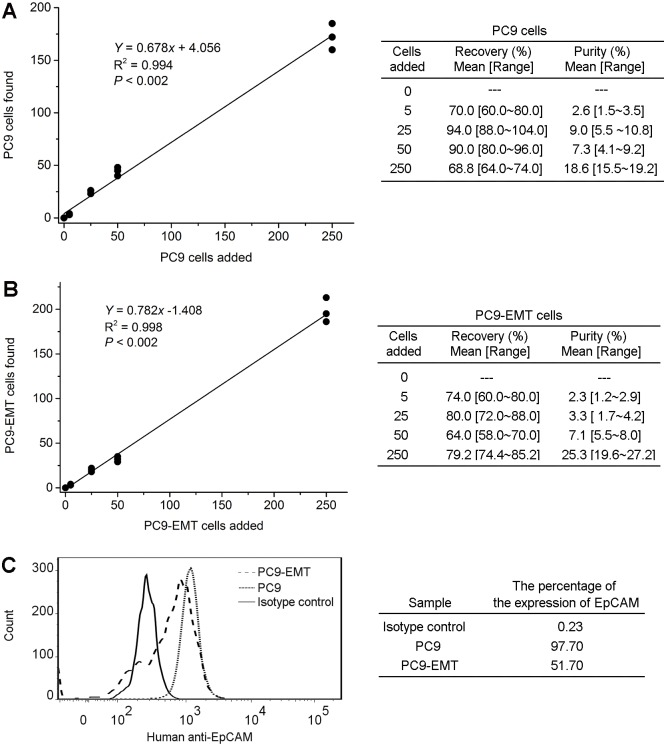

Calibration curves in spiking experiments using (A) PC9 cell line and (B) PC9-EMT cells; (C) FACS analysis for the expression of EpCAM in PC9 and PC9-EMT cells stimulated by 5ng/mL TGF-β for 3 days.